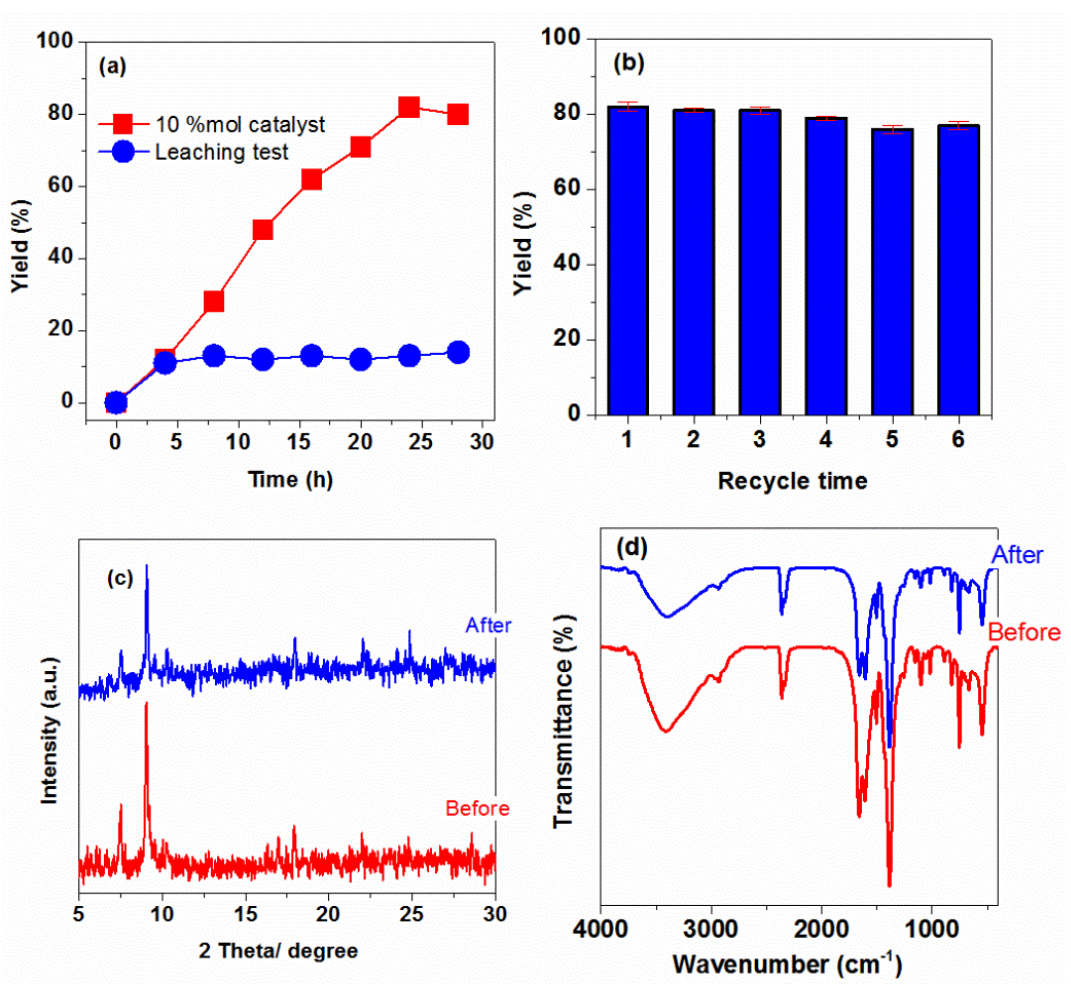
Figure 6. Leaching test ( a ), catalyst reusability ( b ), XRD pattern ( c ), and FT-IR spectroscopy ( d ) of the fresh and recovered catalyst.